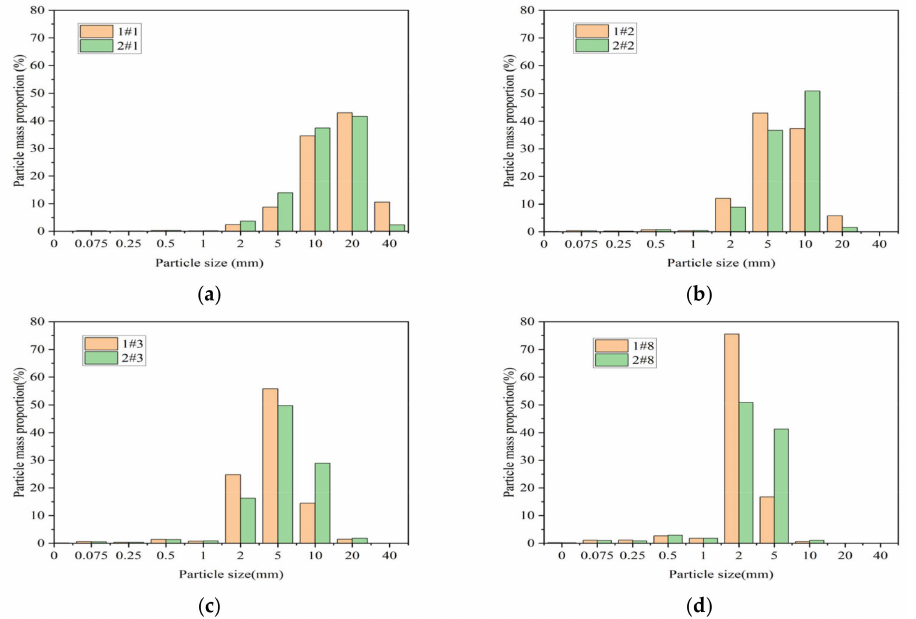
Figure 10. Comparison of particle content variation between first indoor and second outdoor wet and dry cycles: ( a ) the 1st cycle; ( b ) the 2nd cycle; ( c ) the 3rd cycle; ( d ) the 8th